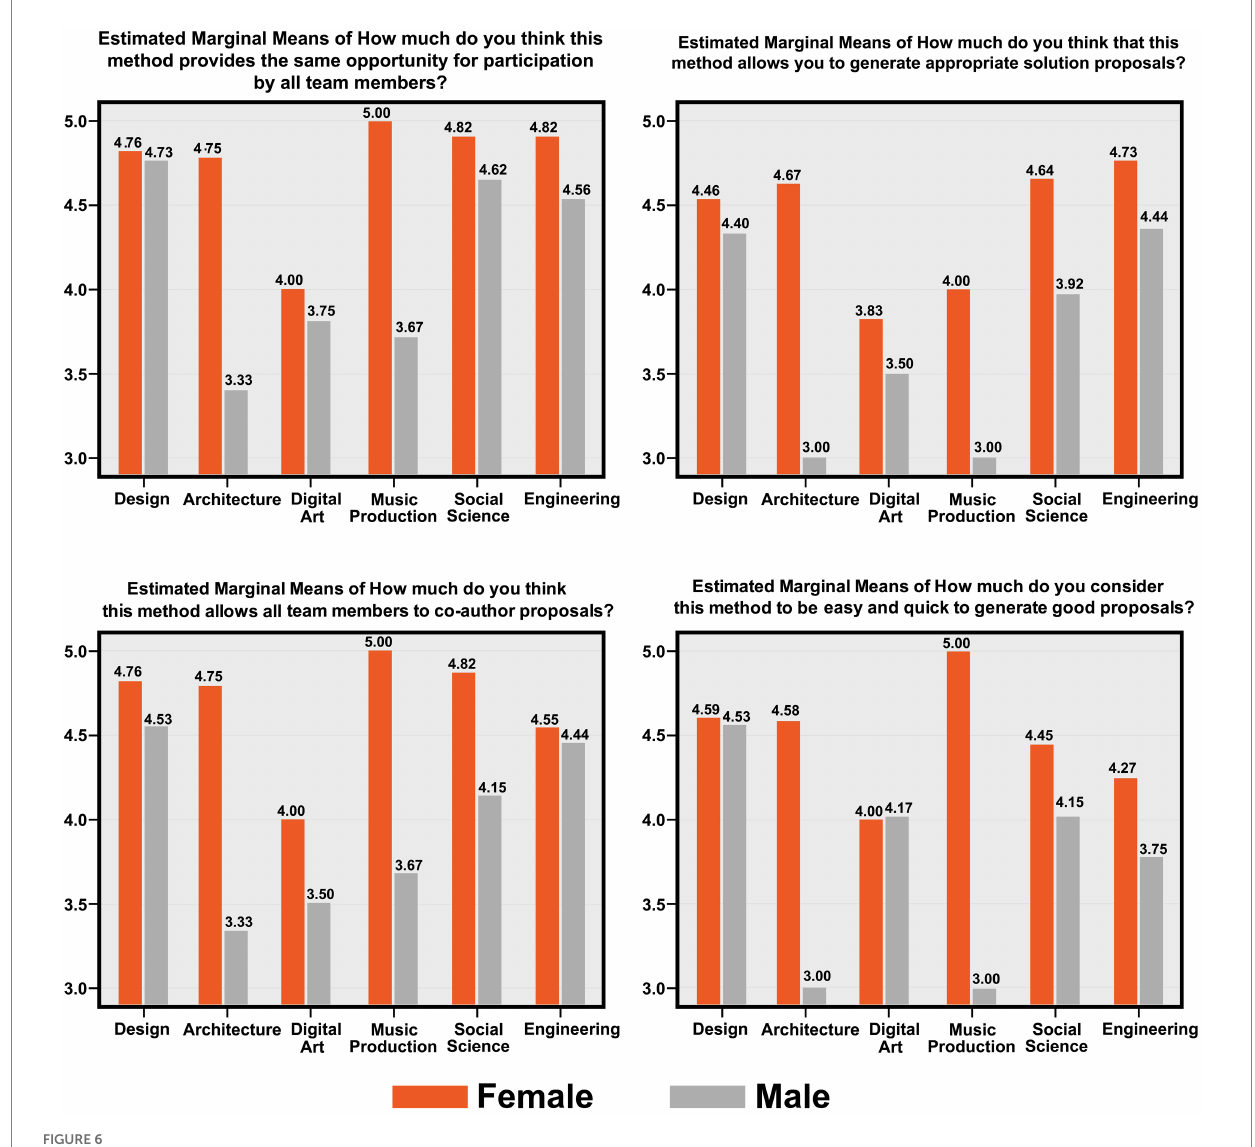
FIGURE 6 Plots of means for gender-career and perception-experience